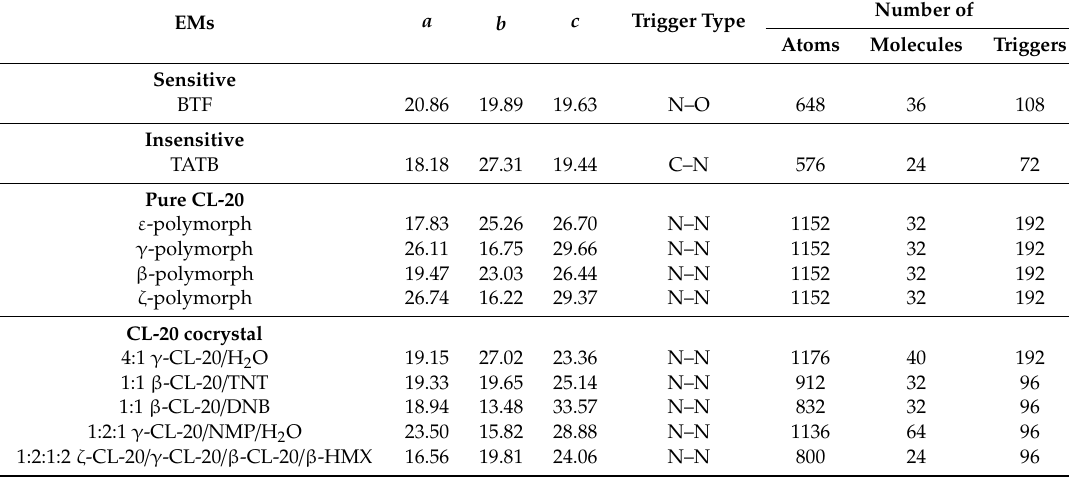
Table 1. Lattice lengths (Å) of the supercells used for shock simulations. The type of the trigger bonds for each crystal, as well as the number of the composed atoms, molecules and trigger bonds in each supercell, are also given. EMs = energetic materials, BTF = benzotrifuroxan, TATB = insensitive explosive triaminotrinitrobenzene, CL-20 = hexanitrohexaazaisowurtzitane, TNT = trinitrotoluene, HMX = single crystal model of